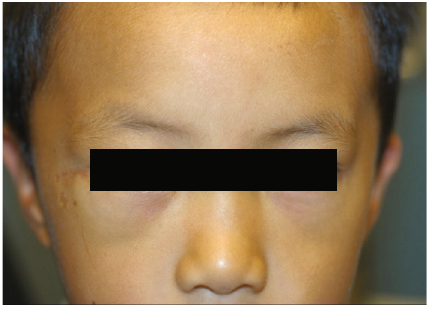
Figure 6: External photograph at the one-month postoperative visit, with resolution of the right orbital